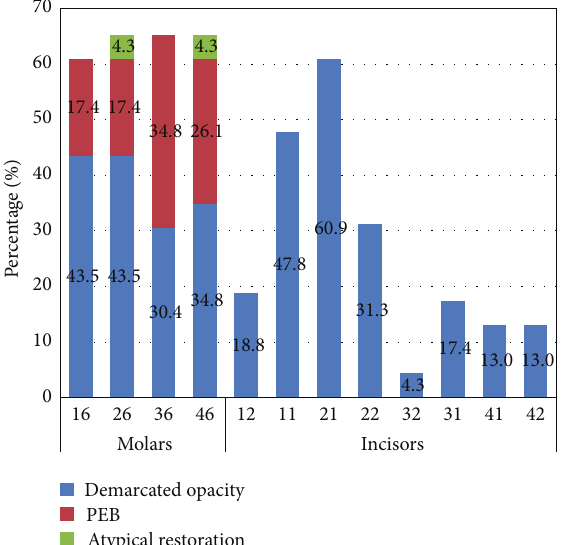
Figure 3: Prevalence of MIH in each permanent index tooth. Upper central incisors were more affected by MIH than lower central incisors ( 𝑃 = 0.01